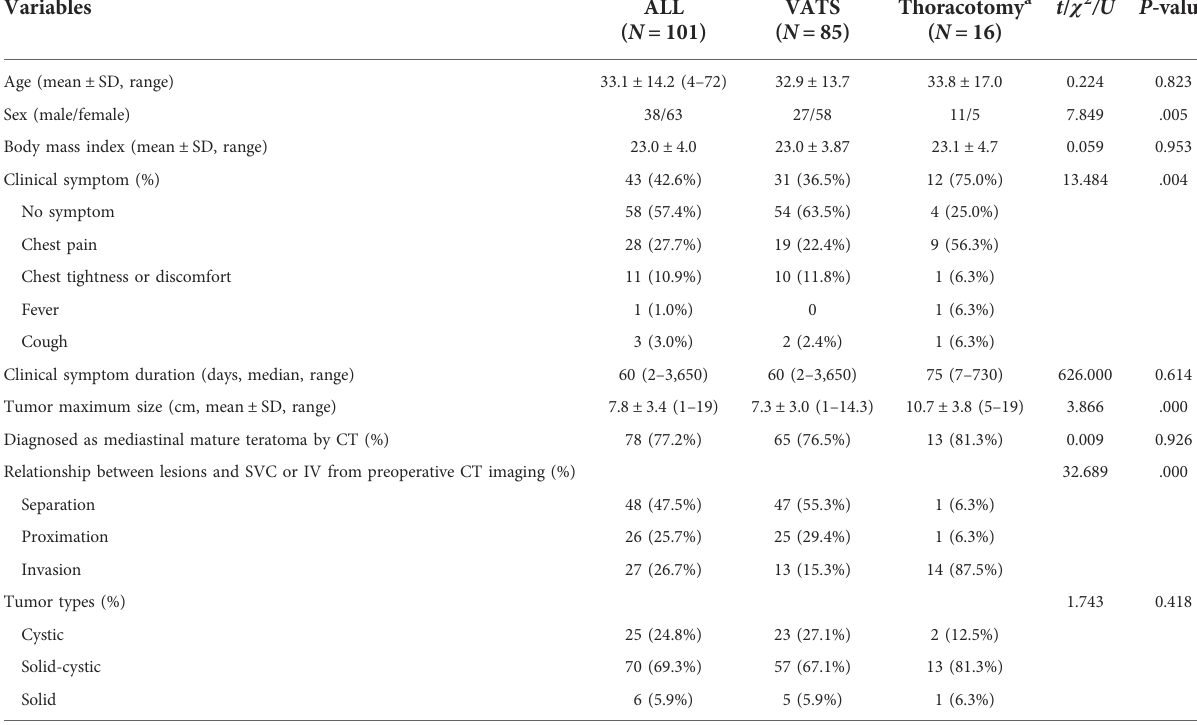
TABLE 1 Demographic and preoperative data of patients with mediastinal mature